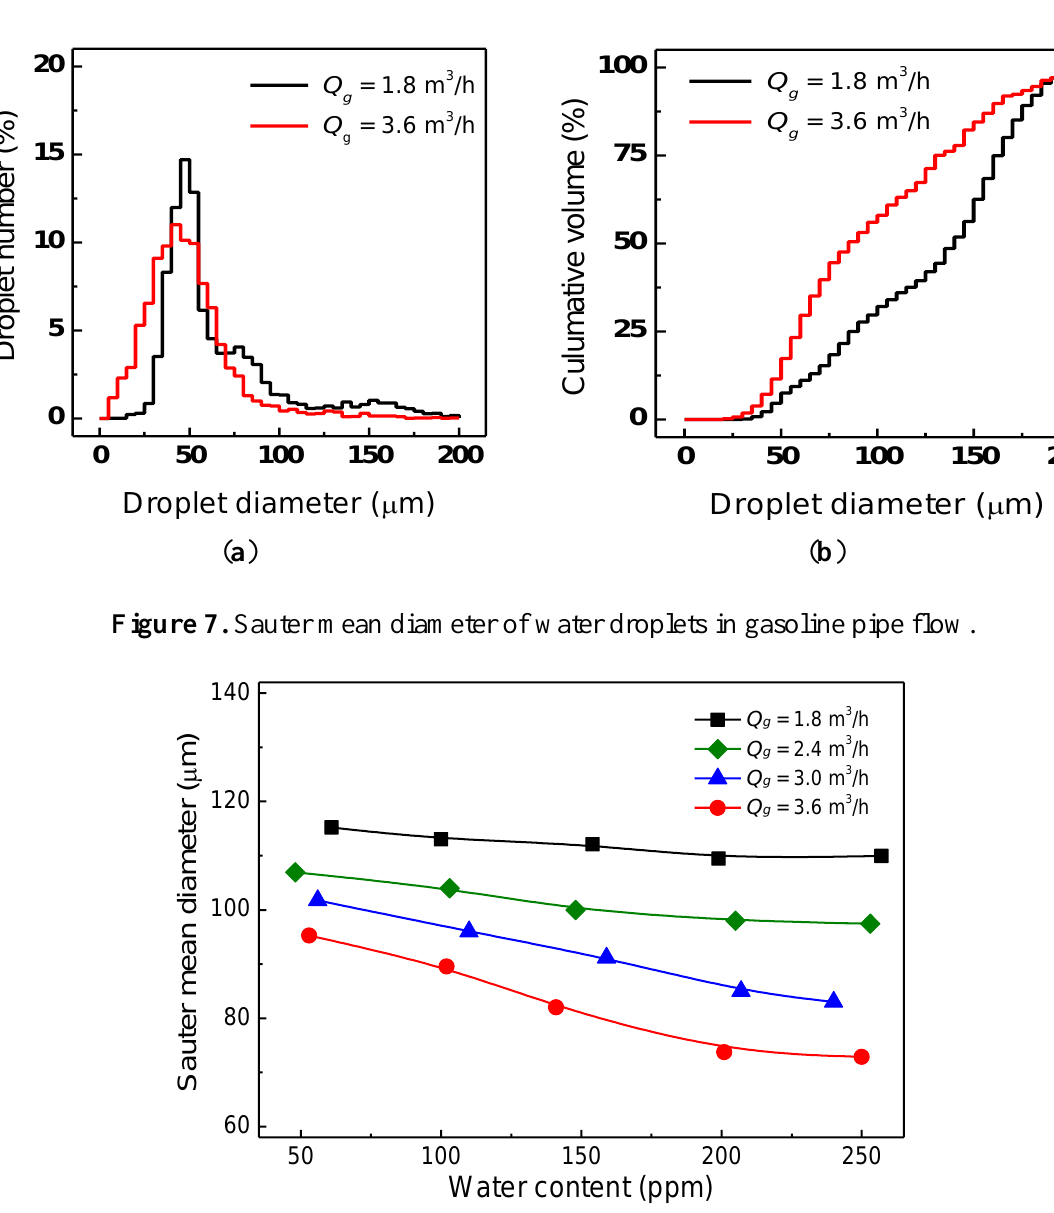
= 3.6 m 3 /h, C = 150 ppm: ( a ) size distribution; ( b ) cumulative g w